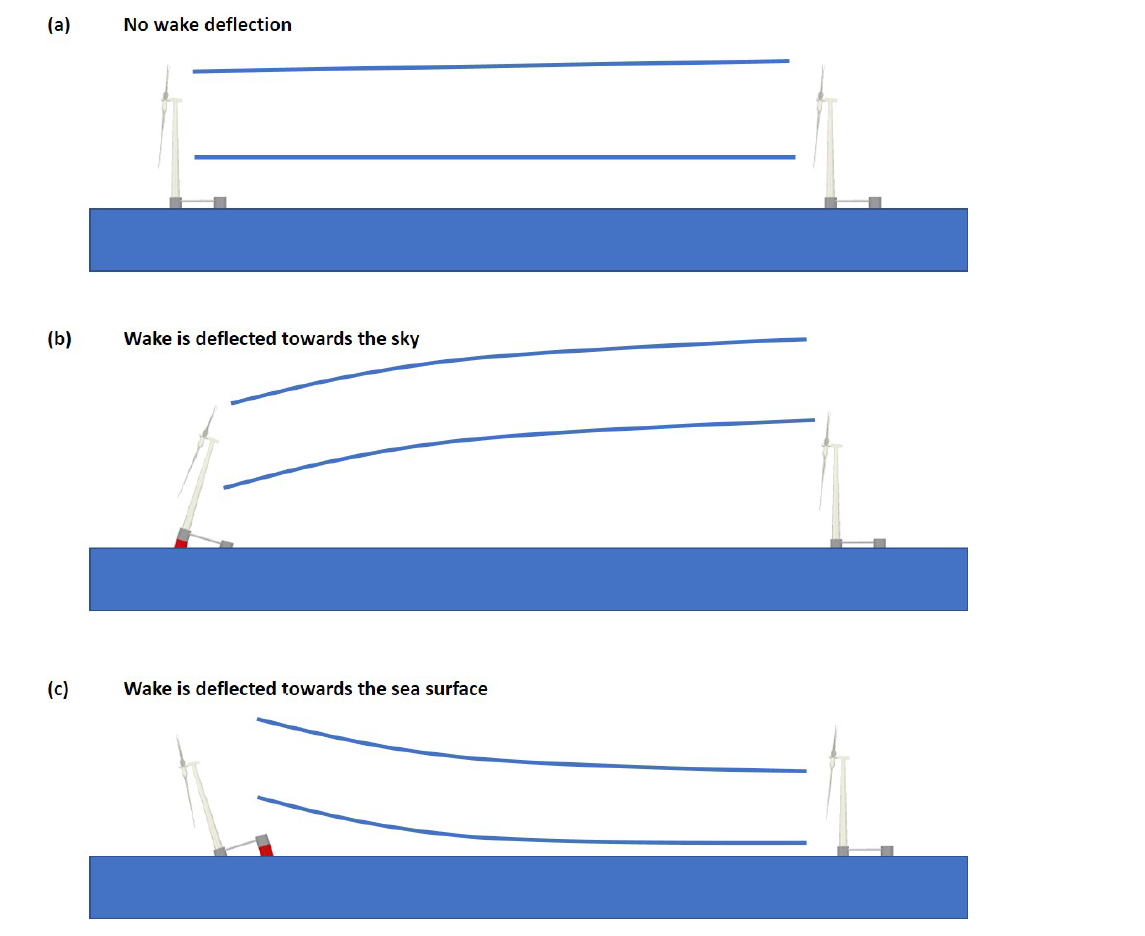
Figure 1. Schematic representation of the vertical wake redirection concept.